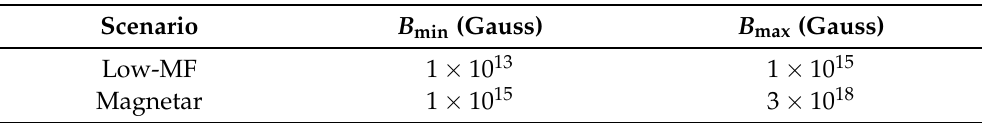
Table 1. MF parametrization values for the two selected astrophysical scenarios: low-MF pulsar and magnetar